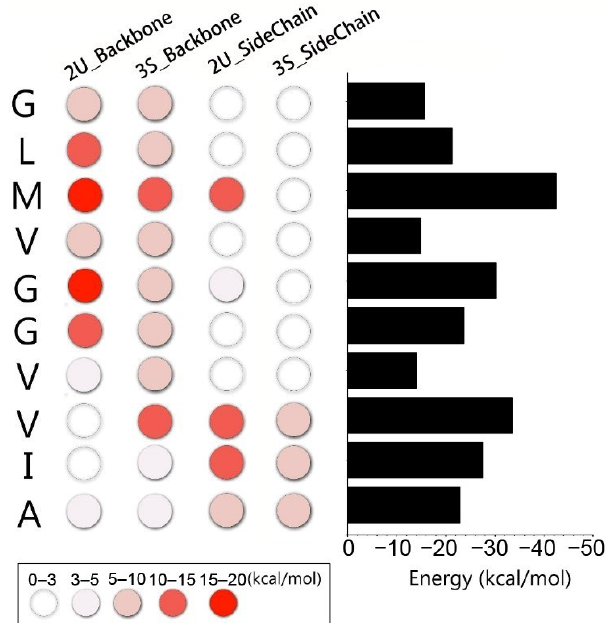
Figure 8. Residue-based interaction energies between gammabody with A β aggregates suggest that M35 could be the most important residue in the grafted A β sequence to interact with A β amyloid. The residue color scheme was based the absolute value of interaction energy. The summed residue interaction energies for four gammabody-A β complexes are shown in the right panel. The interaction energies were based on the average structure from the last 40 ns